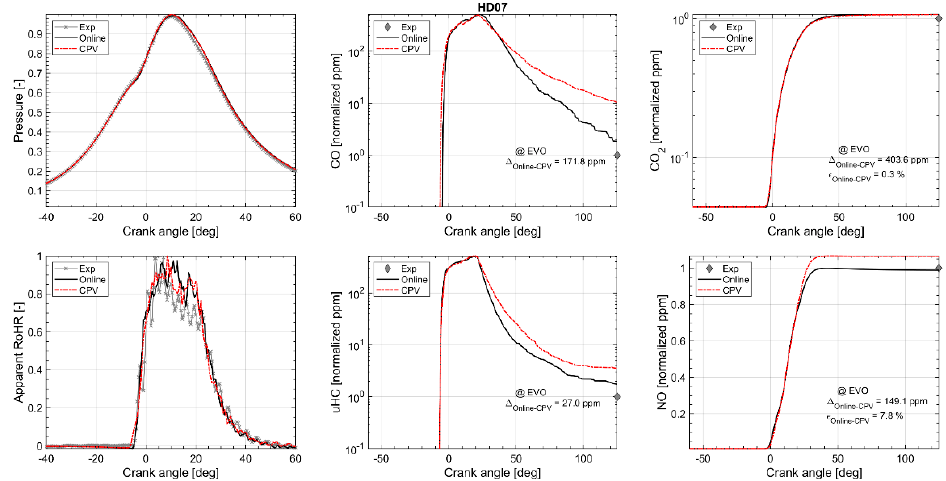
Figure A7. Engine performance and emissions for operating point HD07 (1200 rpm, 22.0 bar IMEP).